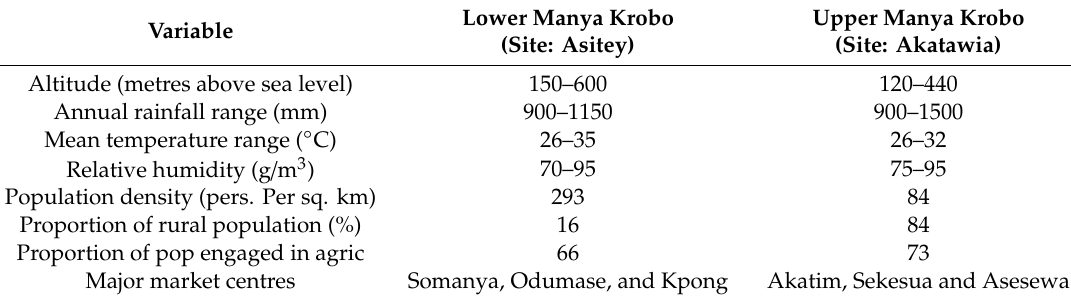
Figure 1. Map of the study districts showing the location of Asitey and Akatawia. Table 1. Geographic, climatic and socioeconomic characteristics of the study districts.